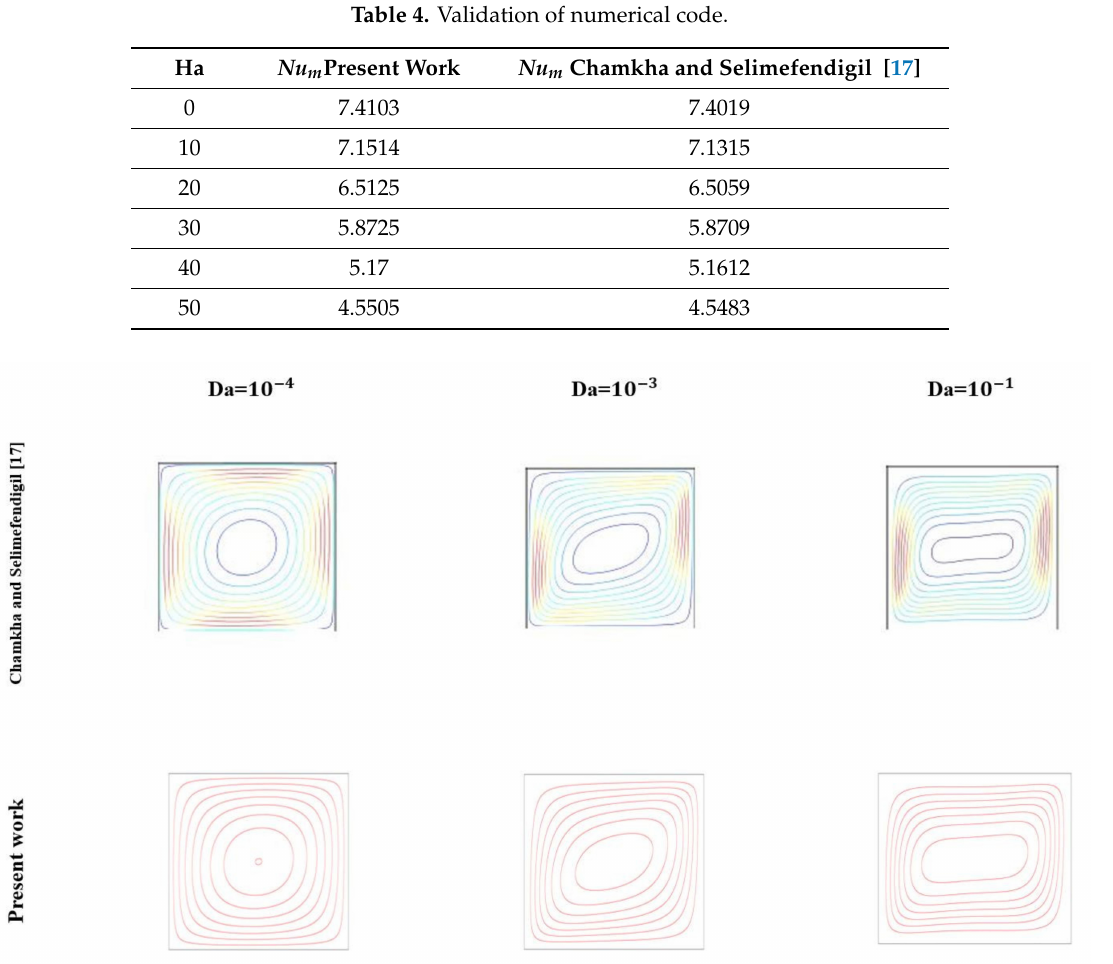
Figure 3. Streamlines for di ff erent Darcy numbers with Grashof number Gr = 10 4 , Ha = 10 and ϕ =